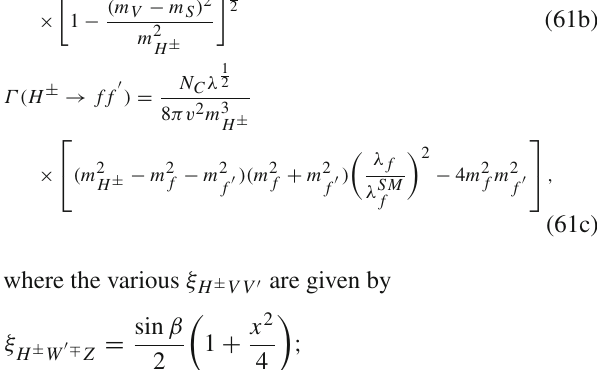
Fig. 14 Allowed regions (in yellow) in the m H ± − sin β parameter space from the experimental measurement of the branching ratio for the decay b → s γ by this measurement in the model